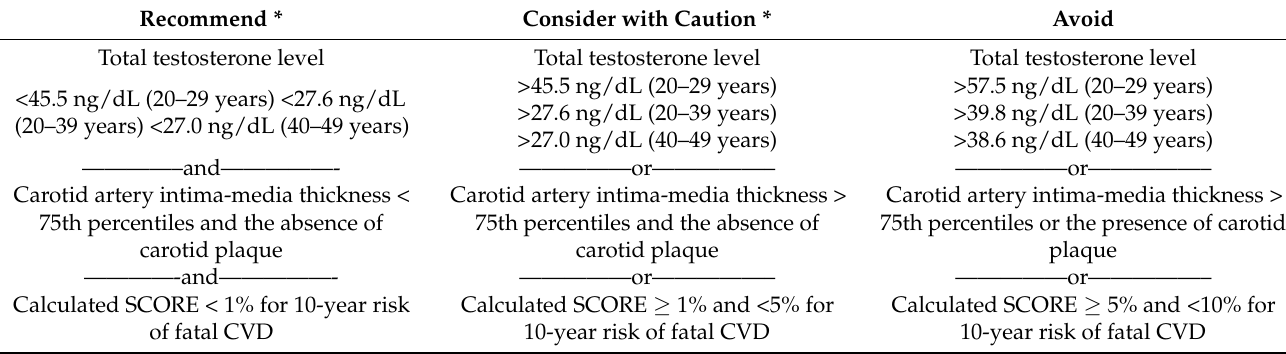
Table 2. Subcutaneous testosterone therapy CV risk assessment protocol (IDEALSTT). * Must include low T symptoms: decreased memory, sense of well-being and libido, reduced muscle mass and bone mass, increased irritability, anxiety, fatigue, and symptoms of depression. CVD: cardiovascular